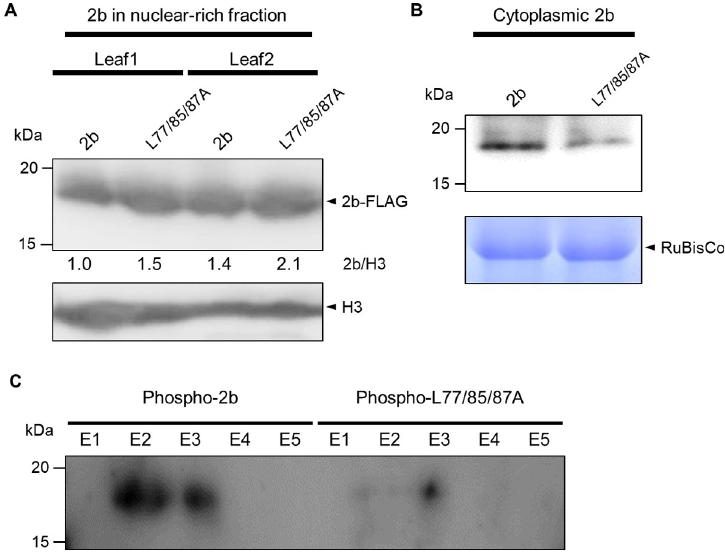
Fig 7. Comparison of levels of phosphorylated 2b in nucleus. (A) Western blot analysis to detect nuclear-localized 2b-FLAG protein in the nuclear-rich fraction from leaves of N . benthamiana expressing the FLAG-tagged 2b and L77/ 85/87A. Histone H3 was detected using anti-H3 antibodies for a loading control. Values below the blot for 2b are the relative ratio of 2b/H3. (B) Detection of cytoplasmic 2b by immunoprecipitation. The cytoplasmic fractions were separated from the total plant extracts by differentiated centrifugation. The 2b-FLAG was immunoprecipitated with anti-2b antibodies and detected in the western blot using anti-FLAG antibody. (C) Detection of phosphorylated 2b in the nuclear fraction. The level of phosphorylated 2b-FLAG in the nuclear-rich fraction was isolated using a phospho- protein enrichment column. Phosphorylated 2b in each elution (E1–5) was detected by western blot using anti-FLAG